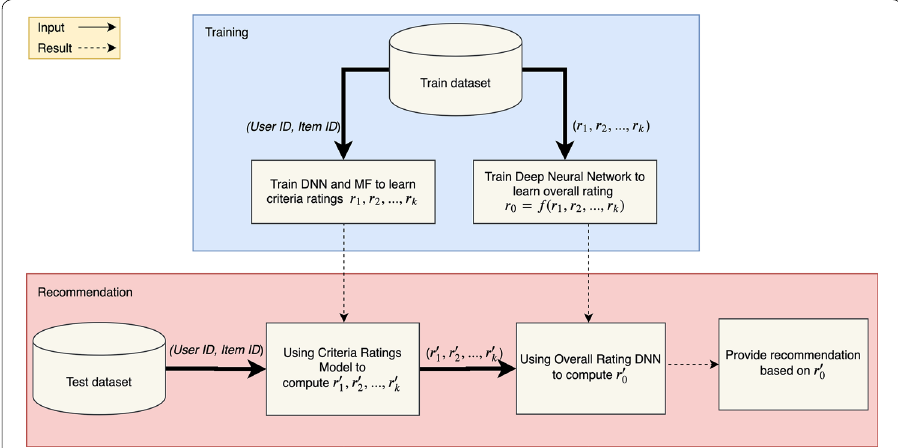
Fig. 1 The framework of the proposed model, including two steps: the Training and the